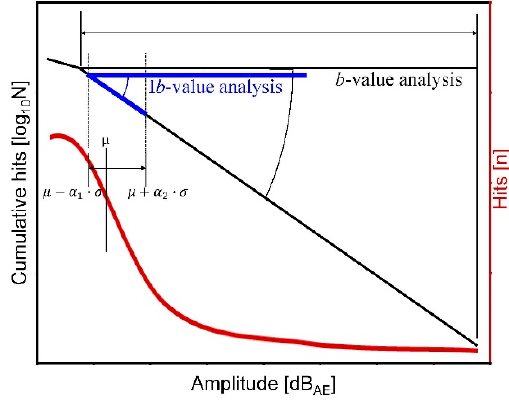
Figure 4. The concept of b - and I b -values